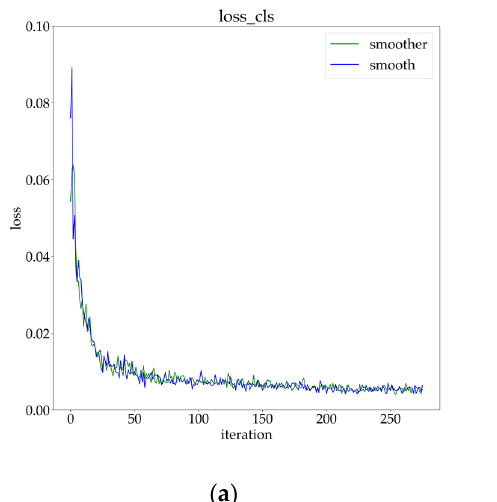
Figure 9. The visualization of training with the smoother L1 ( 𝛼 (cid:3404) 2, 𝛽 (cid:3404) 2 ) and the smooth L1: ( a ) classification loss; ( b ) localization loss in bounding box regression.